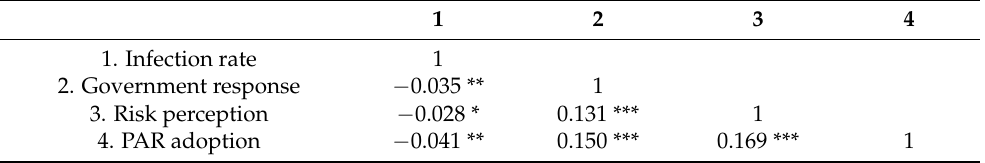
Table 3. Correlations between infection rate, government response, risk perception, and PAR adoption.